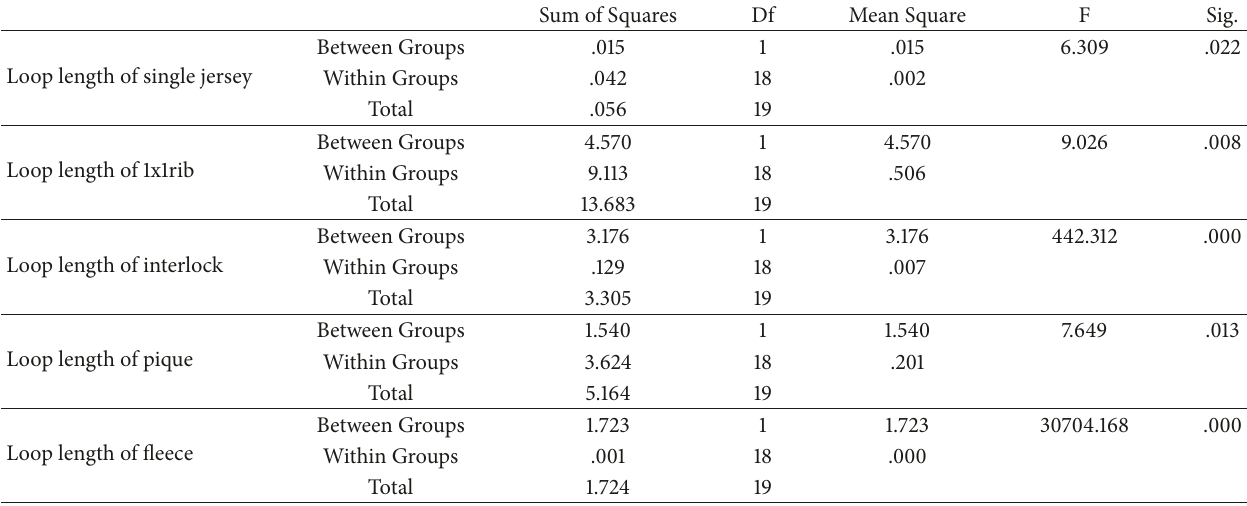
Table 2: Analysis of variances of knitted fabrics loop length made from 100% cotton and cotton/elastane. Sum of Squares Df Mean Square F Sig. Loop length of single jersey